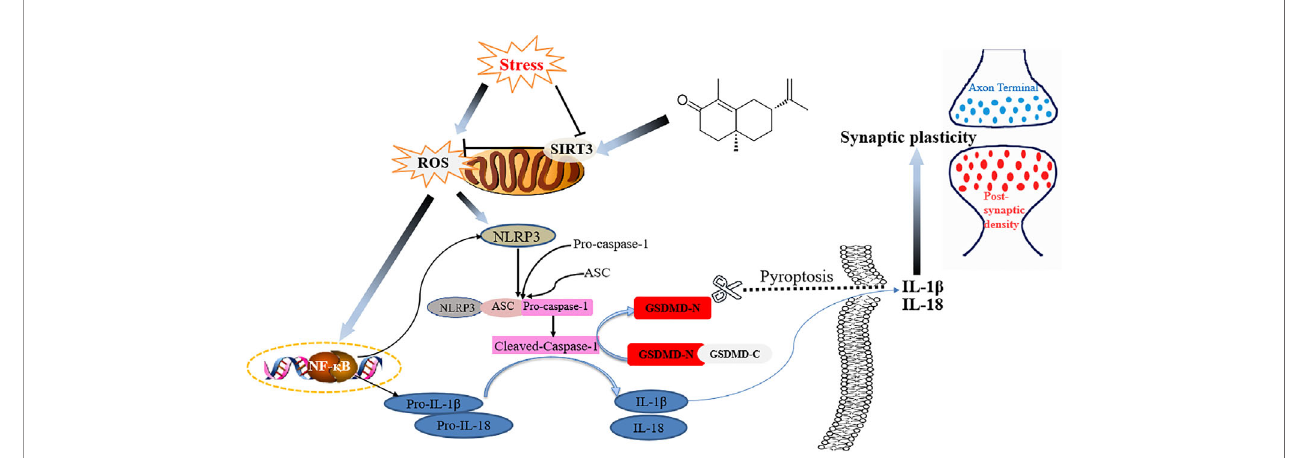
FIGURE 7 | Schematic illustration of the proposed mechanism for Cy to ameliorate